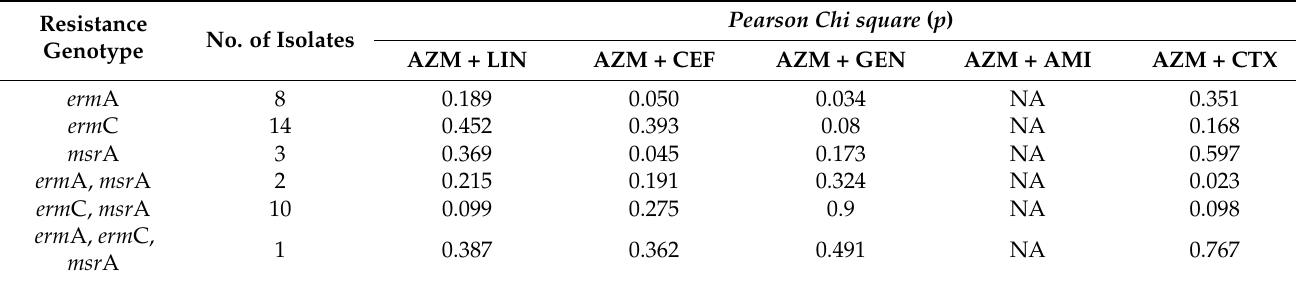
Table 4. Statistical association between MAC resistance genotypes of MRSA isolates and the synergistic effect of different azithromycin combinations and their respective p values.